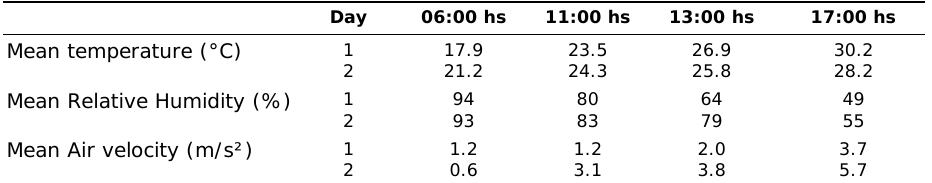
Table 1. Outside air temperature, relative humidity and air velocity data from the measuring days